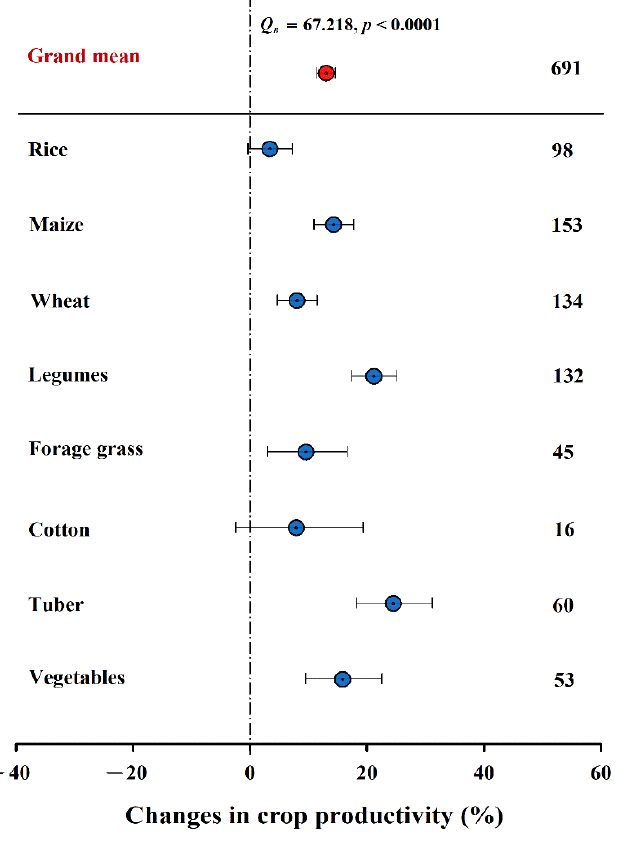
Figure 1. Effects of biochar addition on the productivity of various crops. Data on the right side of each panel represent the number of observations. Bars indicate 95% confidence intervals.